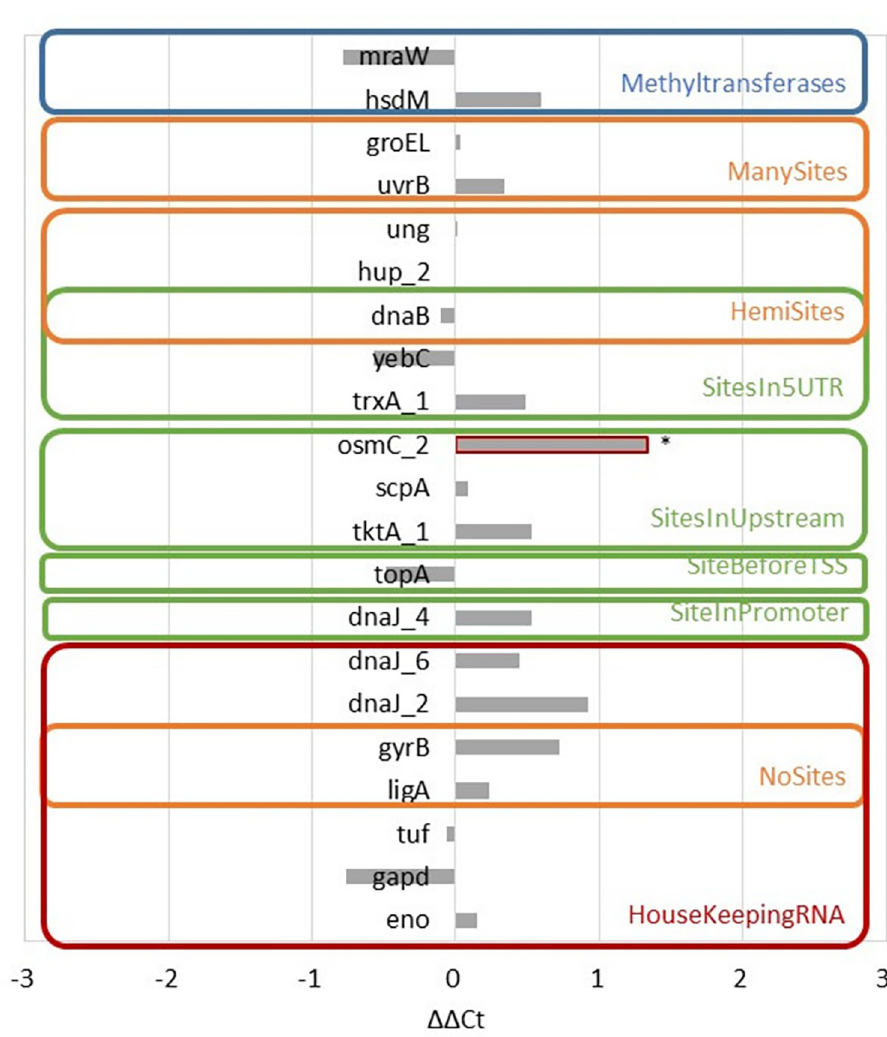
Fig 5. Differences in expression levels of genes with DNA methylations sites between WT and Δ S.MgaS6I strains. Groups of control genes eno , gadp , tuf , ligA , gyrB , dnaJ_2 , and dnaJ_6 ; genes with the methylation motif in promoters topA , dnaJ_4 , tktA_1 , scpA , osmC_2 , trxA_1 , yebC , and dnaB ; genes with different numbers of methylation sites or with hemi-methylation status ligA , gyrB , dnaB , hup_2 , ung , uvrB , and groEL ; genes of methyltransferases hsdM from MgaS6I and mraW have been presented. Genes with significant difference between strains (Student’s t -test, Benjamini–Hochberg correction, P < 0.05) are shown using red boxes and asterisks.